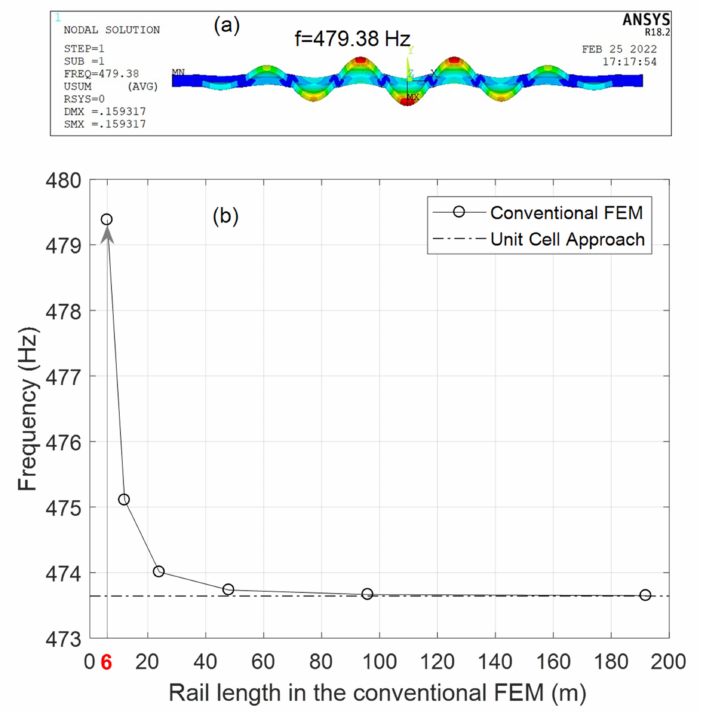
Figure 3. Comparative analysis of the performance of the unit-cell formulation to a conventional finite element approach. The analysis involved a 6-m long rail under pin-pin condition. ( a ) Mode-shape and corresponding frequency obtained with a conventional approach. ( b ) Frequency vs. length of the simulated rail using the conventional FE model and the unit-cell